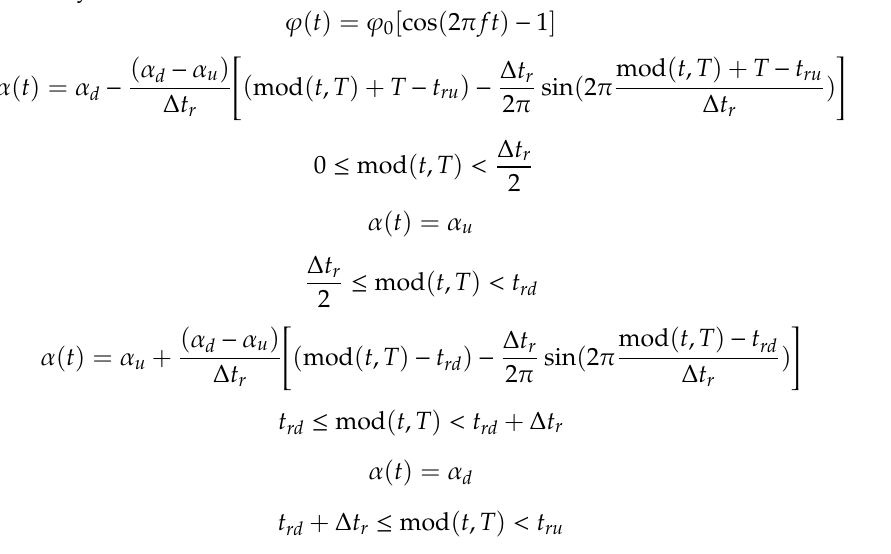
Figure 3. Sketch of the flapping motion of the wing.